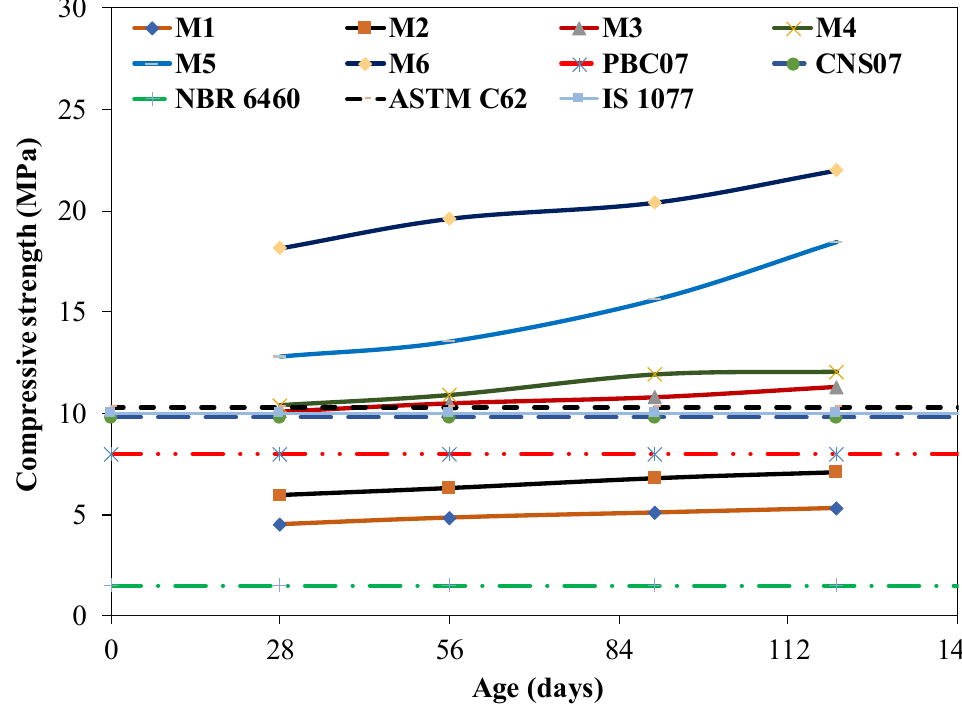
Figure 10. Compressive strength according to curing time.